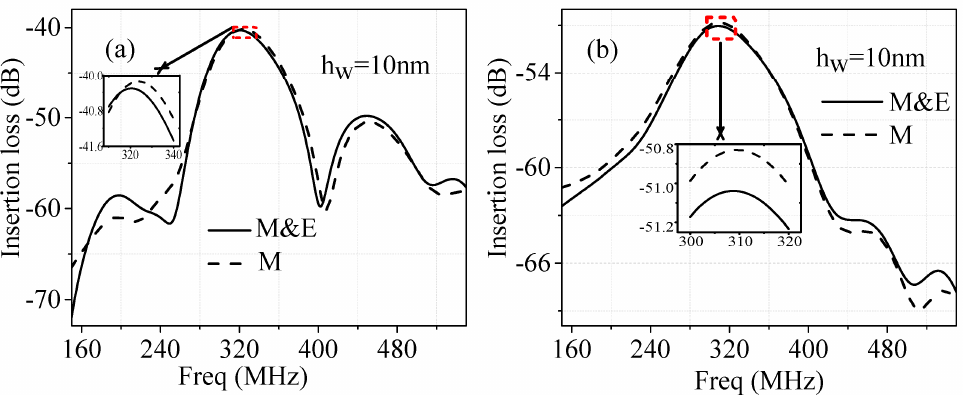
Figure 7. Frequency spectra of insertion loss induced by mechanical (M) and both mechanical and electrical (M & E) effects of the water layer: ( a ) Rayleigh wave sensor; ( b ) Love wave sensor.